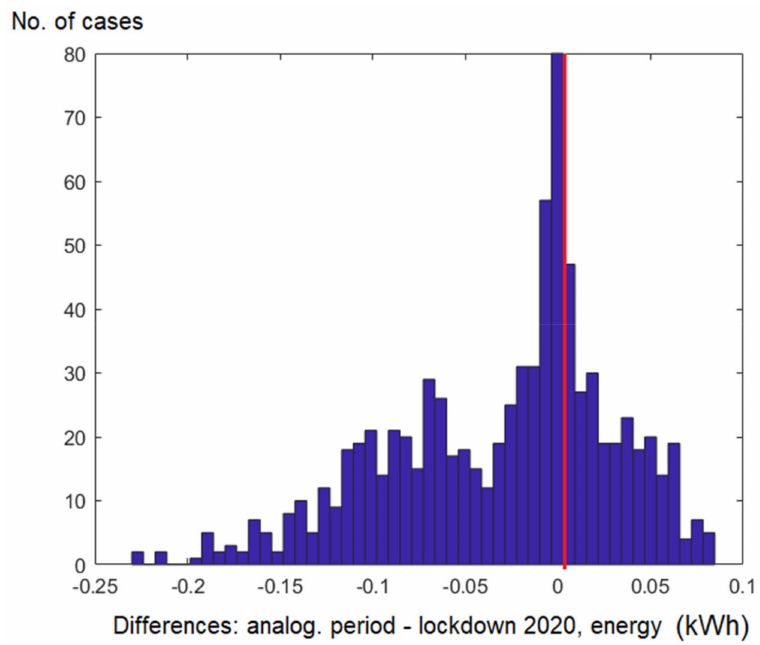
Figure 15. Histogram of the absolute values of the differences between the average active energy consumption of the analysed group of dwellings during the 815 hours between the analogous period in 2018 and the lockdown in 2020 (negative values indicate a higher load during the lockdown than the analogous period in